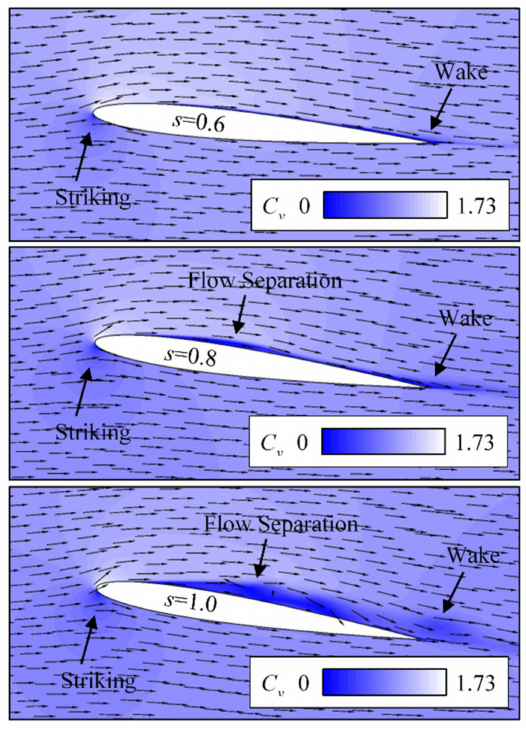
Figure 9. Velocity coefficient C v at different spanwise s positions with indication of velocity